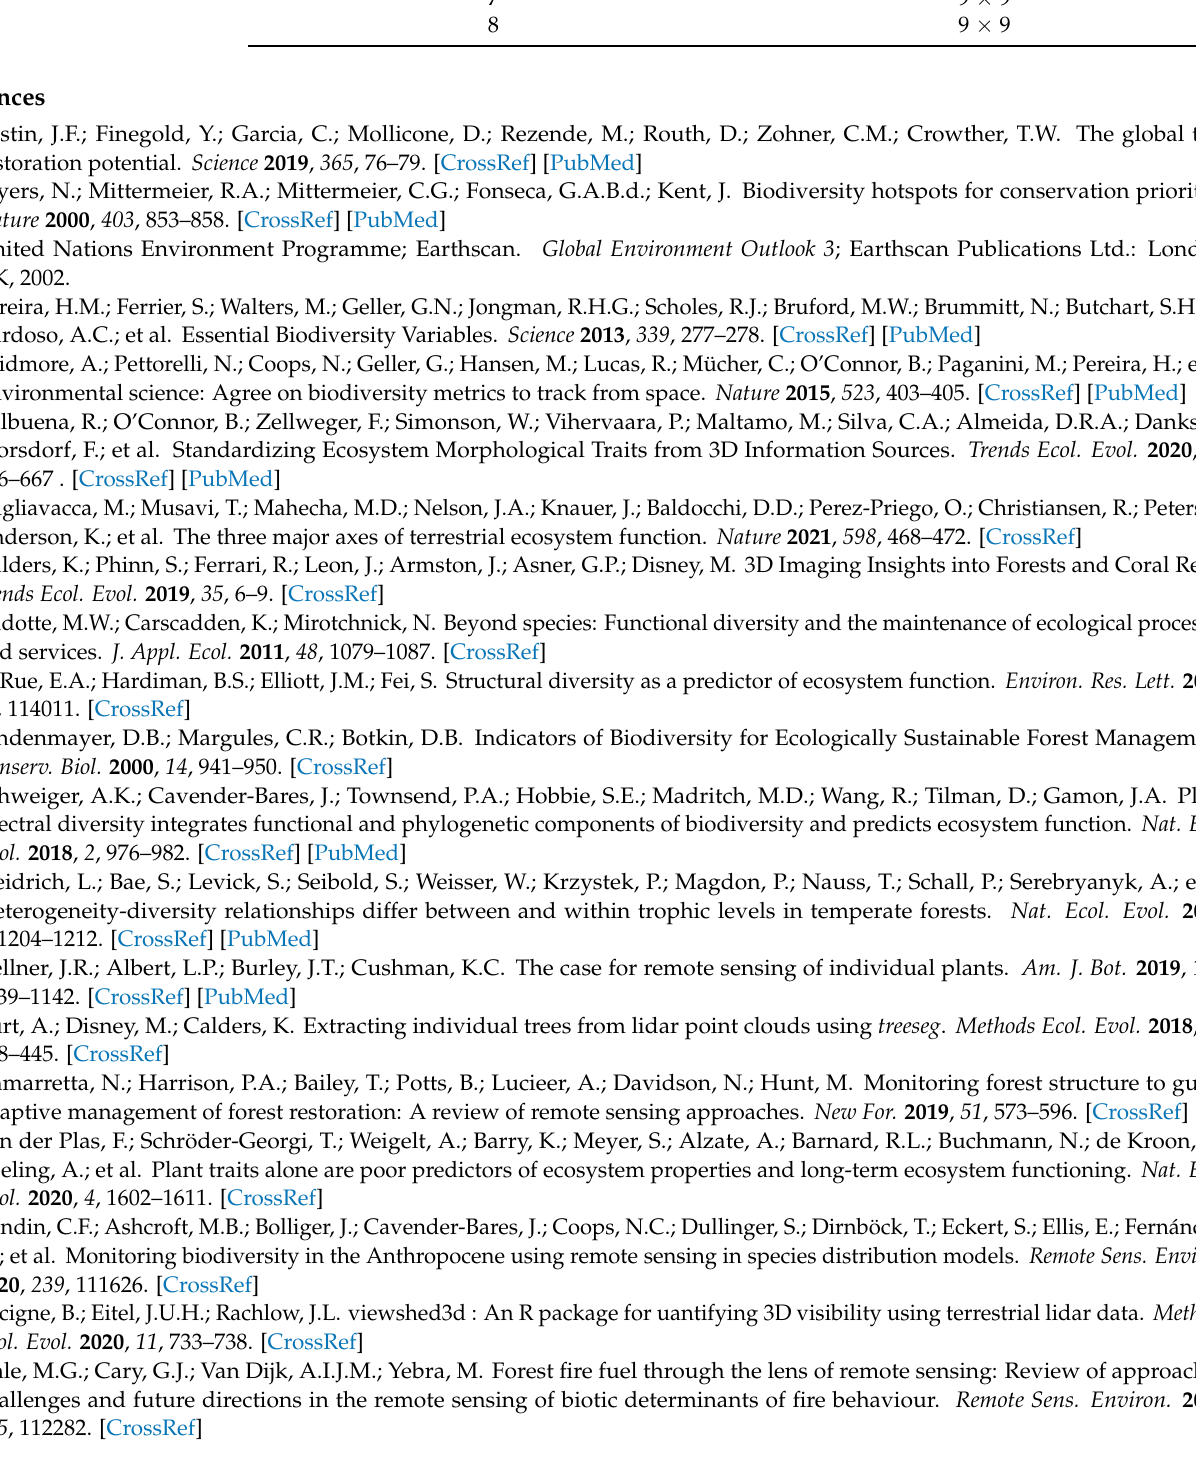
Table A22. Recommended minimum kernel sizes for number of traits based on Kernelsize